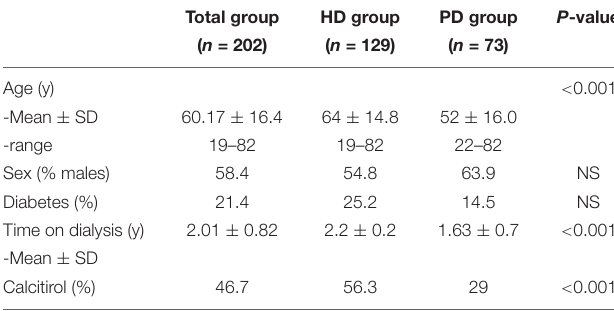
TABLE 1 | Baseline characteristics of the